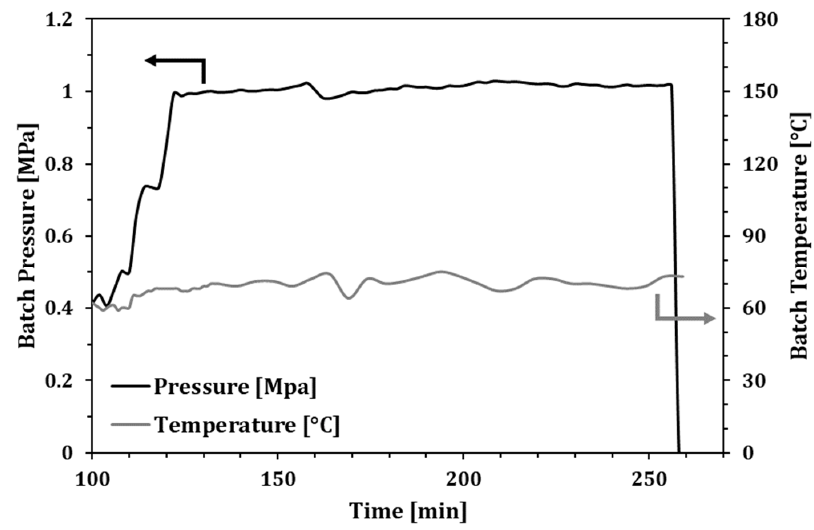
Figure 3. Batch pressure and temperature along Exp. 3.